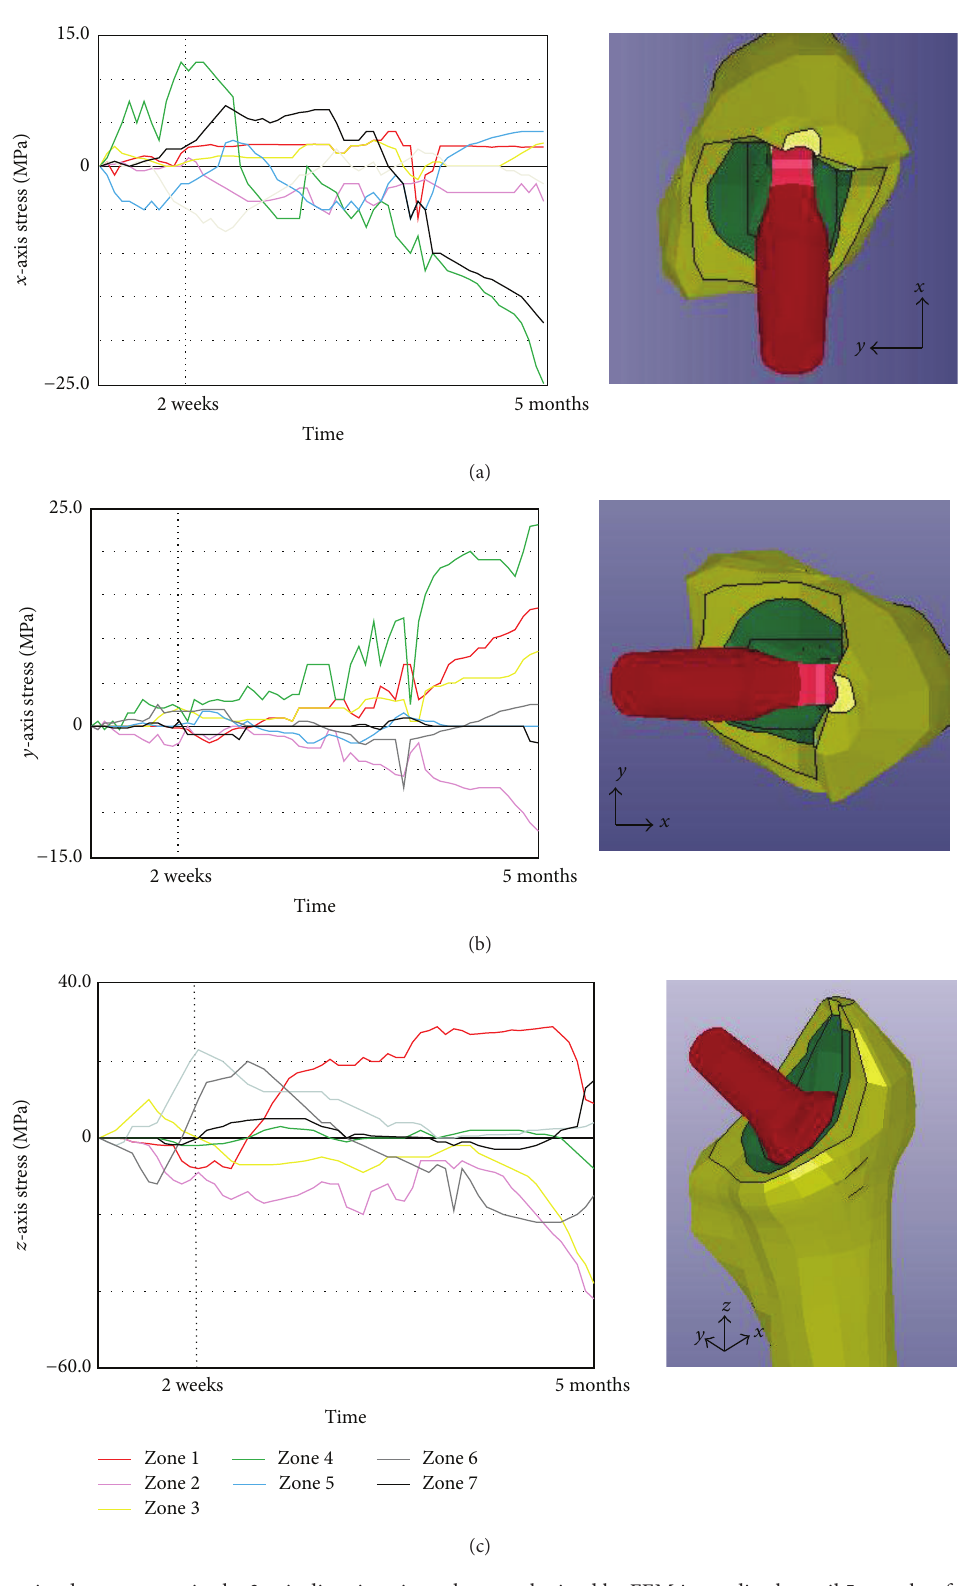
Figure 6: Time series data on stress in the 3 axis directions in each zone obtained by FEM immediately until 5 months after the operation. (a) x -axis (medial-lateral) direction. (b) y -axis (anterior-posterior) direction. (c) z -axis (sinking)